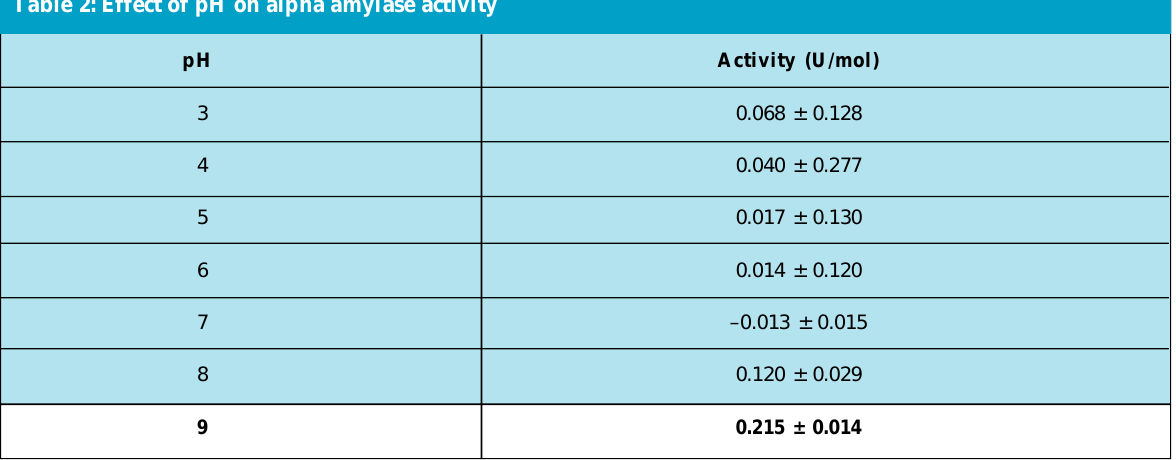
Table 2: Effect of pH on alpha amylase activity